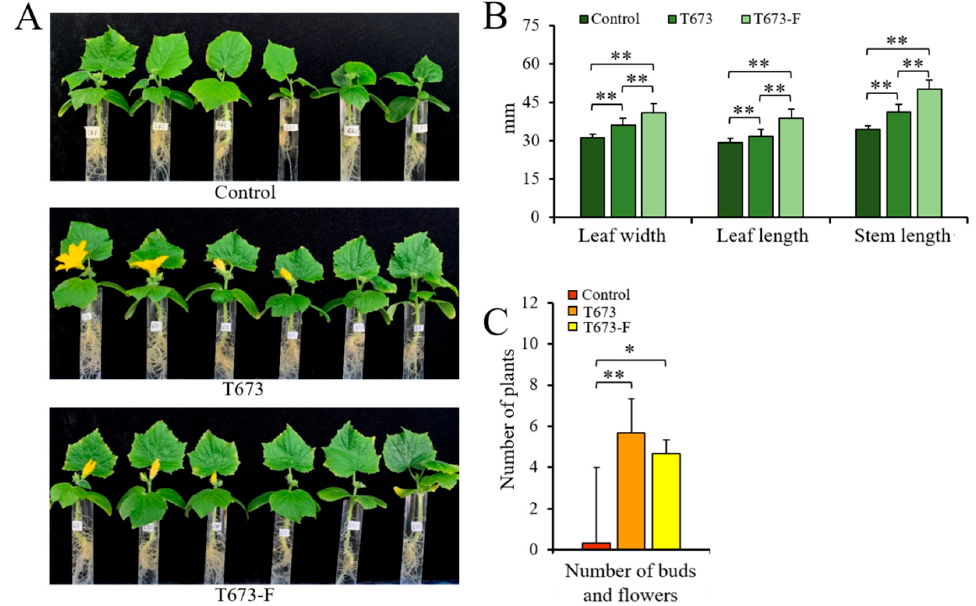
Figure Figure 5. Effect of T. harzianum strains T673 or T673-F on cucumber plant development. ( A ): Pheno- type of plants seed-dipped with T. harzianum strains T673 and T673-F. Non-treated plants served as controls. ( B ): Effect of treatment with strains T673 or T673-F on leaf width and length, as well as on stem length. Non-treated plants served as controls. ( C ): Effect of treatment with strains T673 or T673- F on budding and flowering of cucumber plants. Control plants remained non-inoculated. Every